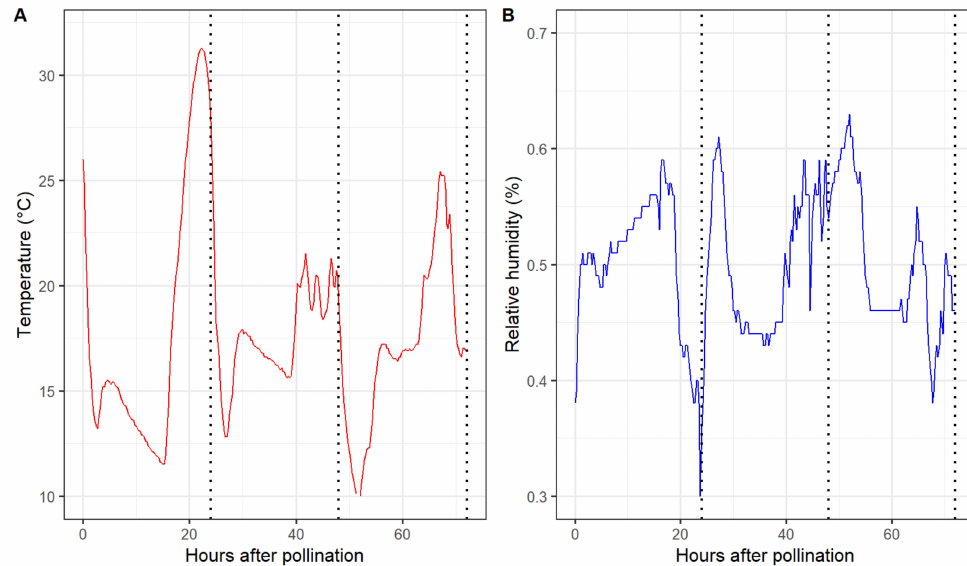
Figure 4. Air temperature ( A ) and relative humidity ( B ) during the experimental period inside the greenhouse. Dotted vertical line represents the sampling time points 24, 48, and 72 h after